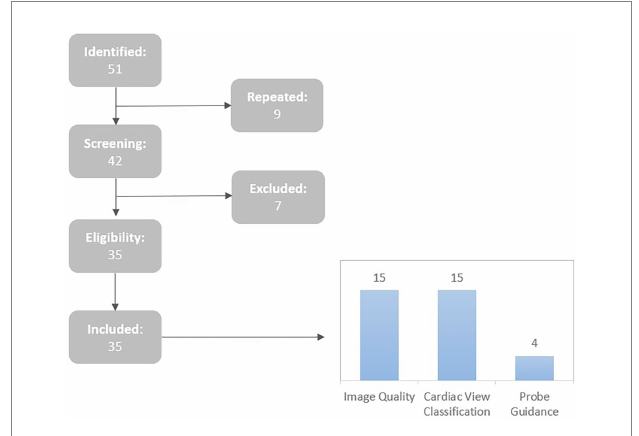
FIGURE 1 Summary of the article selection process and sorting of the included articles by acquisition